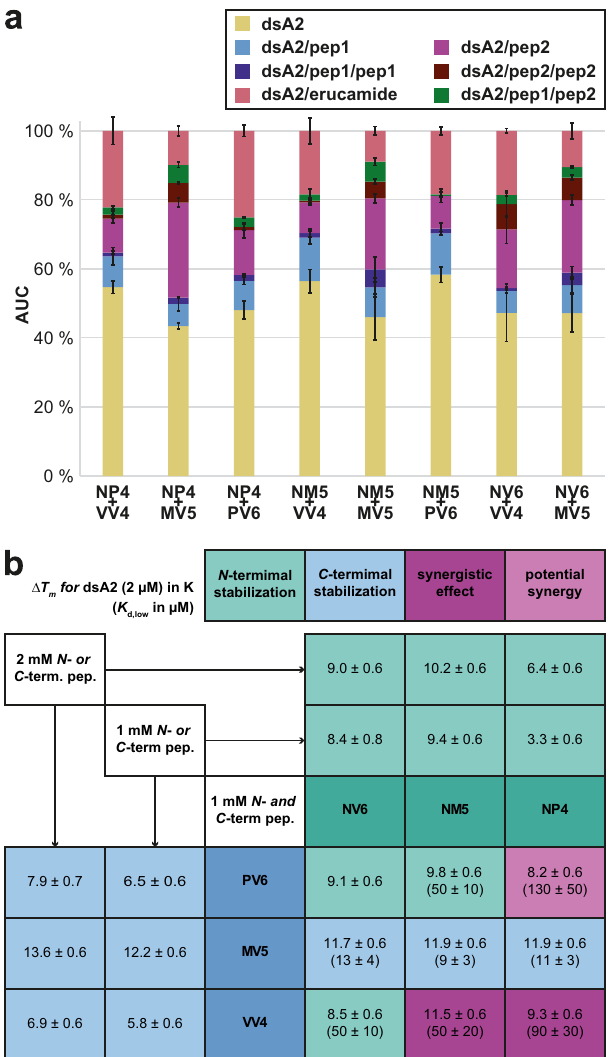
Fig. 7 Detected dsA2 mass species in presence of two corresponding truncated NV9 variants. a The native MS data suggest that the truncated peptides do not bind cooperatively as the amount of dsA2/pep1/pep2 remains small in all measurements. Rather, the af fi nity of the individual peptides is independent of each other. The AUC is determined over the entire spectrum for the respective mass species at 10 V. The mean value of the AUC in the absence or presence of the different peptides (protein – peptide ratio 1:10:10) from at least three independent measurements is depicted along with error bars that represent the corresponding standard deviation. “ dsA2 ” (yellow bars) corresponds to the empty HLA-A*02:01(Y84C/A139C) disul fi de mutant complex, “ dsA2/pep ” (light blue bars) to dsA2 bound to one peptide, “ dsA2/pep/pep ” to dsA2 bound to two molecules of this certain peptide (dark blue bars), “ dsA2/ pep2 ” to dsA2 bound to another peptide when two different peptides were present (purple bars), “ dsA2/pep2/pep2 ” to dsA2 bound to two molecules of the second peptide (dark red bars), “ dsA2/pep1/pep2 ” to dsA2 bound to one molecule of each of both peptides (dark green bars) and “ dsA2/ erucamide ” to dsA2 bound to the erucamide (coral bars) respectively. The corresponding K d,low is shown for respective peptide pairs in ( b ). b The matrix visualizes the changes of T m in case half of the peptide amount is either exchanged for the corresponding N - (teal) or C -terminal (blue) peptide respectively or alternatively omitted. Teal marks the occurrence of major N -terminal stabilization whereas, for the light blue cells, the complex is primarily stabilized by the C -terminal peptide. Purple cells show peptide coupling with a signi fi cant synergistic effect or potential synergy (light